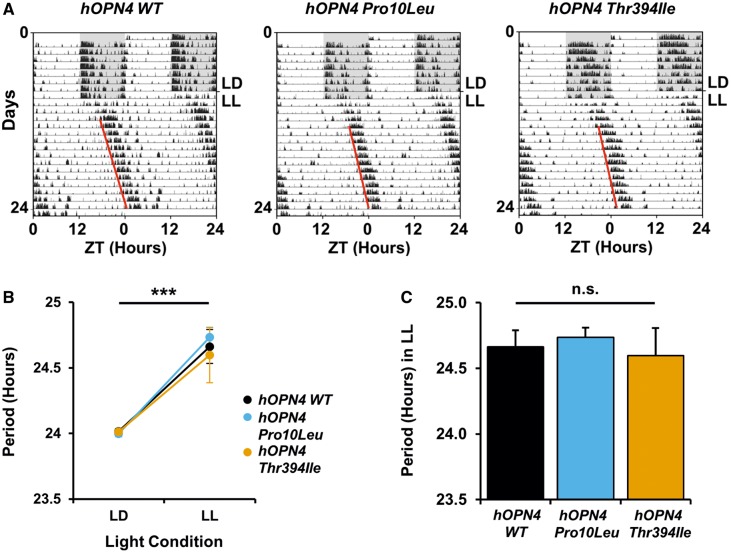
Period lengthening in constant light is comparable between Opn4−/− Cre+/+ mice treated with hOPN4 Pro10Leu, Thr394Ile and hOPN4 WT control AAV. (A) Representative actograms showing activity recorded by PIR detection from three Opn4−/− Cre+/+ mice after bilateral intraocular injection of hOPN4 WT (left), Pro10Leu (middle) and Thr394Ile AAV (right). Animals were in 12: 12 LD cycle under white light (∼350 lux) for 8 days, then released into constant white light at 100 lux (LL) for 16 days. Actograms are double plotted on a 24 h time scale. Grey shading indicates periods of darkness. Activity data displayed in 1 min bins. (B) Comparison of period length (tau) in 12: 12 LD and LL after injection shows similar increase in period duration for hOPN4 WT, Pro10Leu and Thr394Ile treated mice. *** P < 0.001 Main effect of injection, two-way mixed ANOVA. (C) Period in LL is similar in all three hOPN4 AAV conditions. n = 4–7 for each group. n.s. = not significant, one-way ANOVA. Data are shown ± S.E.M. Error bars smaller than symbols are not shown.